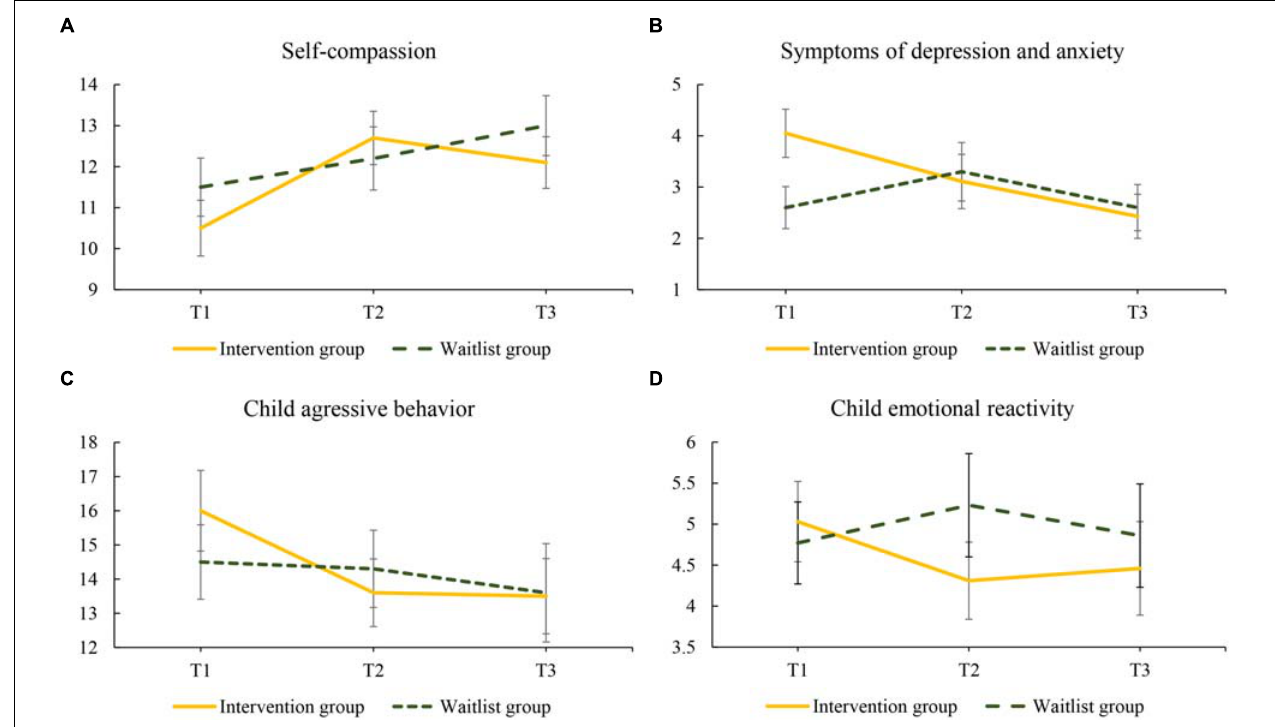
FIGURE 3 | Changes in mean scores regarding (A) self-compassion, (B) symptoms of depression and anxiety, (C) child aggressive behavior, and (D) child emotional reactivity for women in the intervention and waitlist group over the 20-week study period: T1 to T2 (0–10 weeks) and T2 to T3 (10–20 weeks). Intervention group assessments: T1, pretest; T2, posttest; T3, follow-up; Waitlist group assessment: T1, waitlist; T2, pretest; T3